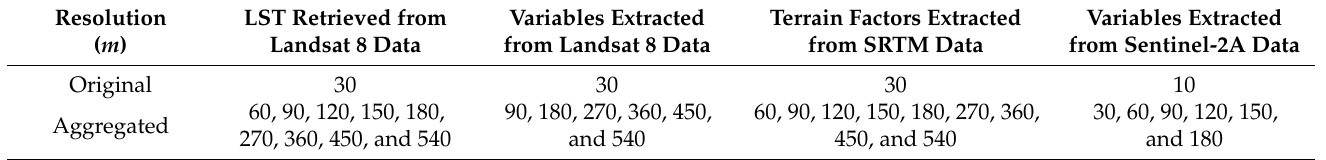
Table 4. Original and aggregated spatial resolutions of the